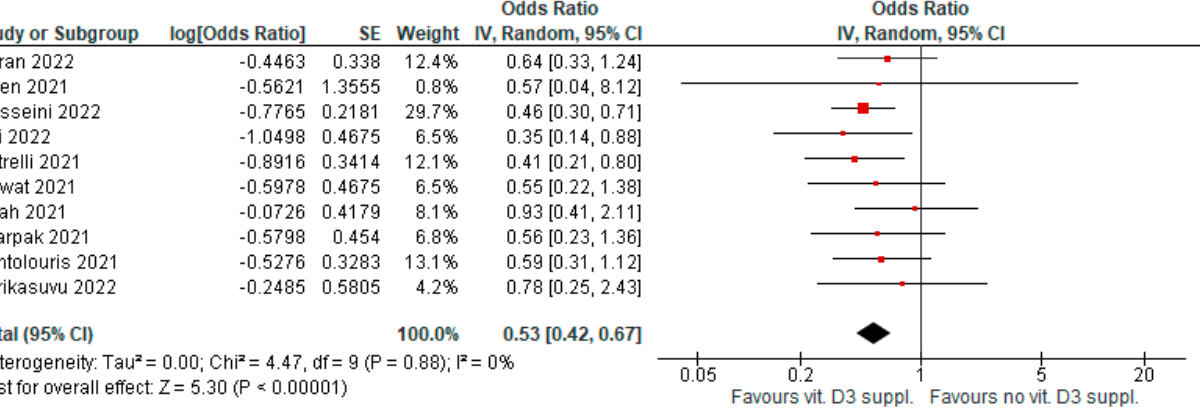
Figure 6. Forest plot showing results for the association of vitamin D3 supplementation and COVID- 19